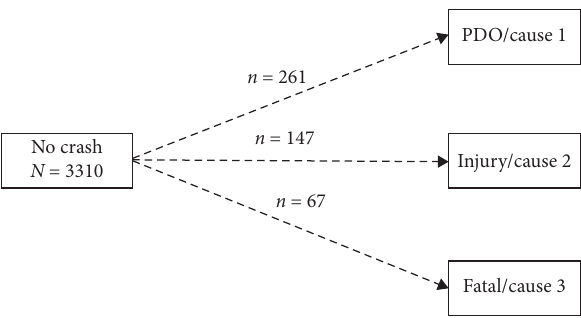
Figure 1: HRGC crash competing risks modeling